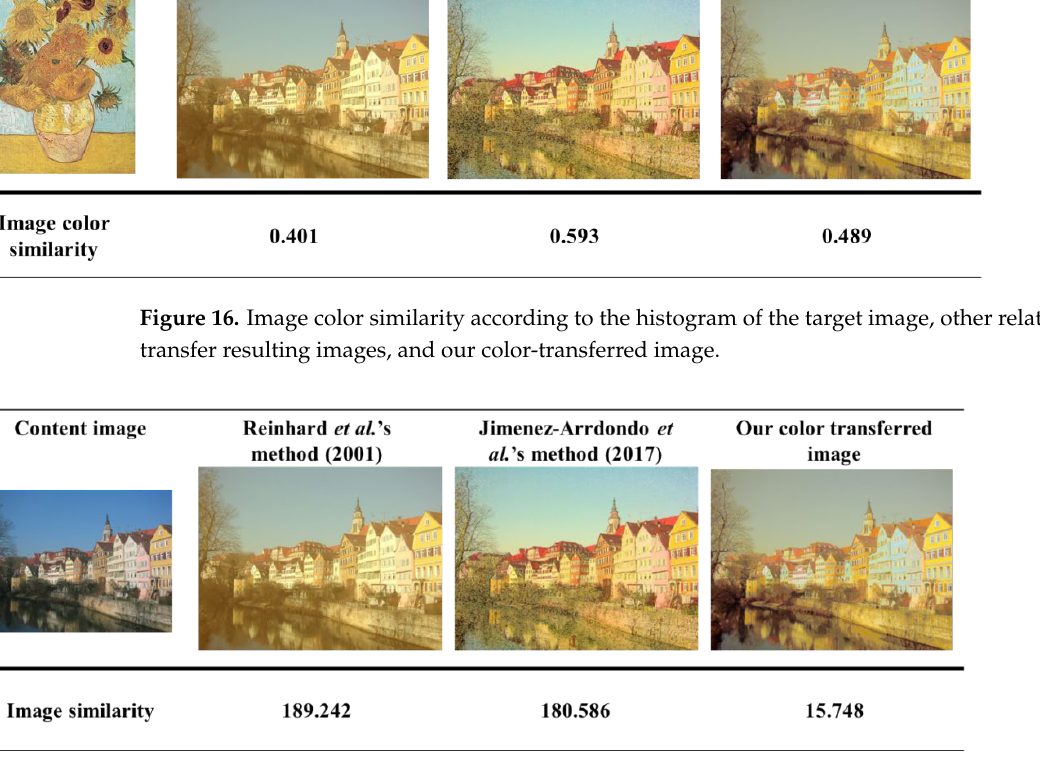
Figure 17. Image similarity between the content image, other related color transfer resulting images, and our color-transferred image.